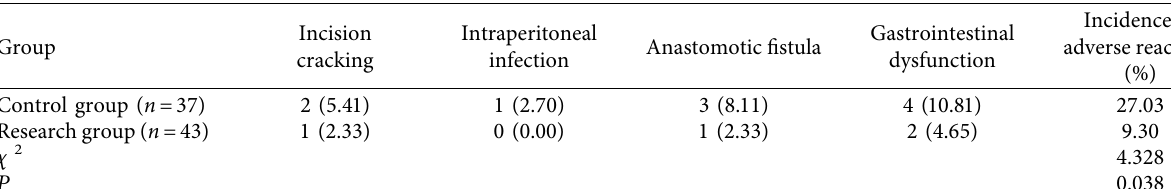
Figure 3: Comparison of changes in psychology between two groups. Note: (a) comparison of SAS scores before and after nursing; (b) comparison of SDS scores before and after nursing. ∗ P < 0.05. Table 3: Comparison of adverse reactions.